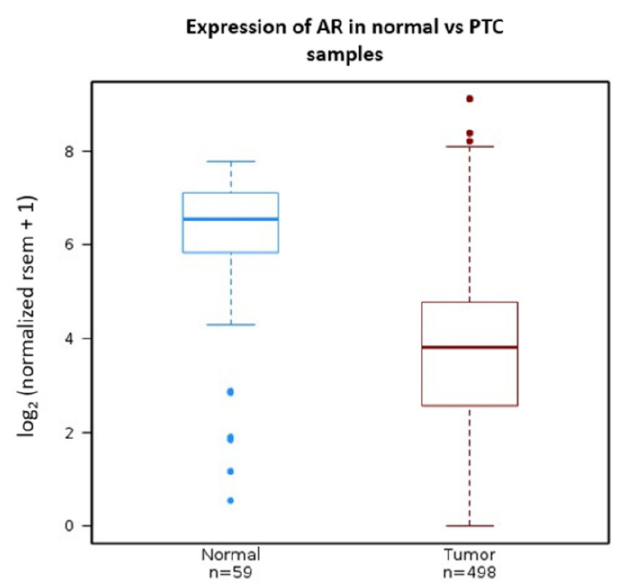
Figure 1. Expression of ARs in PTC samples compared to normal control tissue: TCGA data visualized for AR RNA in tumor and normal samples using Wanderer, a Maplab tool for TCGA RNA data visualization, demonstrated a statistically significant decrease in AR expression in PTC (Wilcoxon p = 8.323325 × 10 − 18